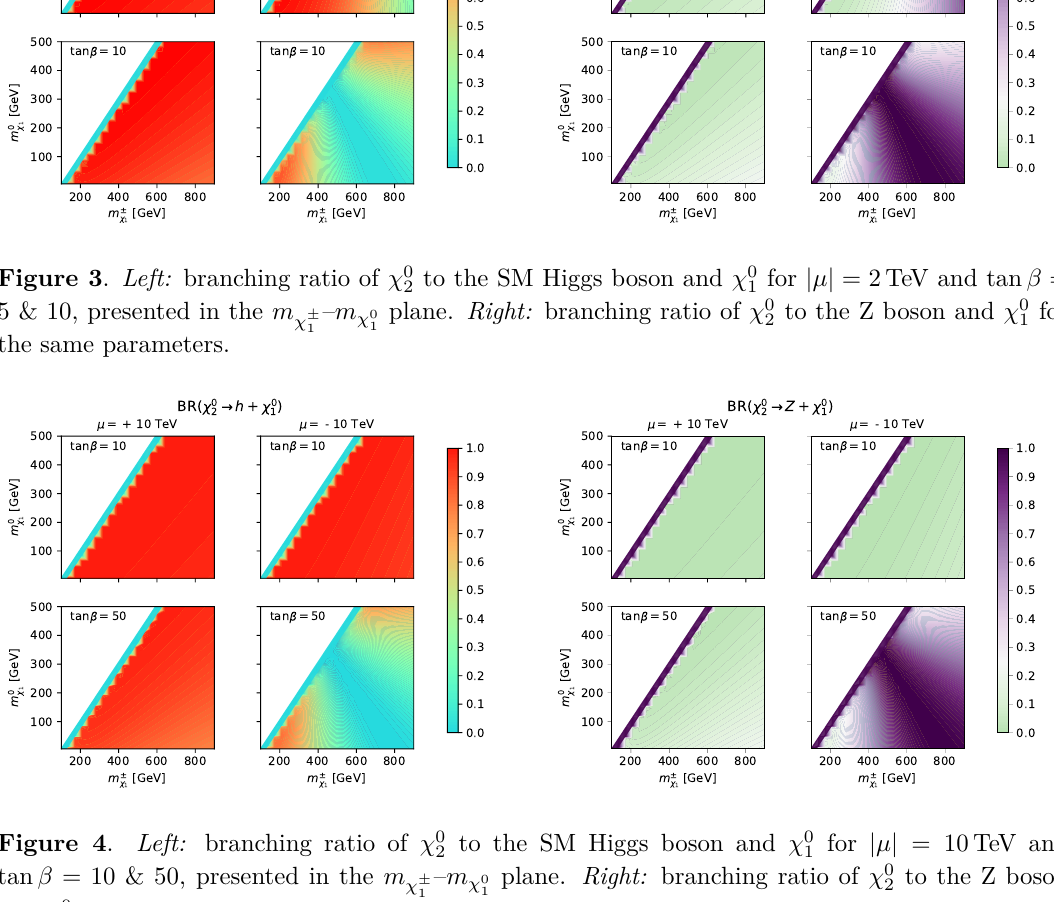
Figure 4 . Left: branching ratio of χ 0 tan β = 10 & 50 , presented in the m for the same and χ 0 1